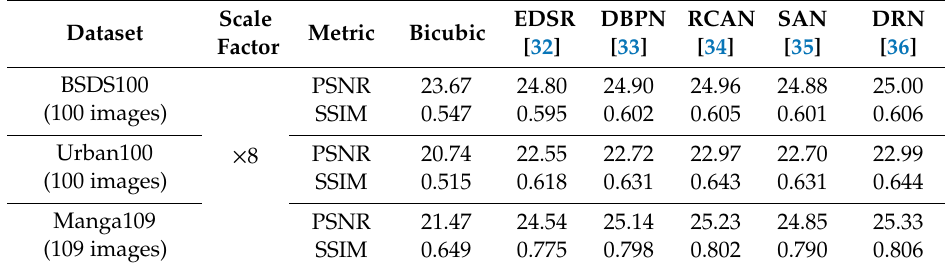
Table 4. Comparison of the quantitative super-resolution quality of the BSDS100, Urban100, and Manga109 databases in terms of average PSNR (dB) and